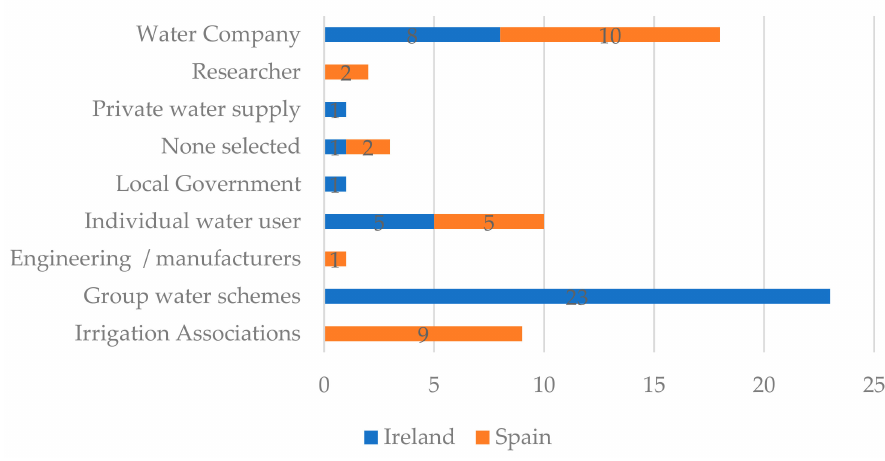
Figure 3. Distribution of the categories of stakeholder respondents in Ireland and